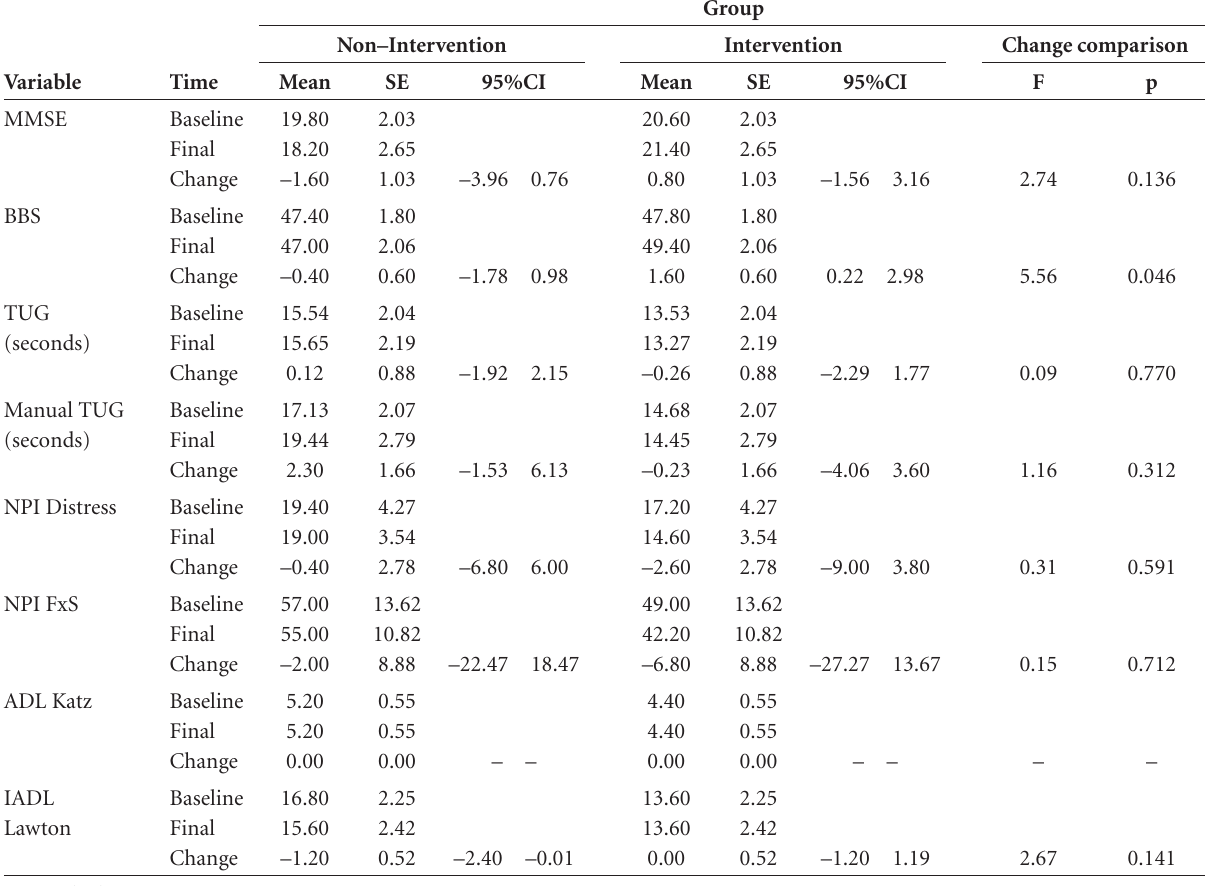
Table 3. Summary of results for intervention and non-intervention groups at baseline and